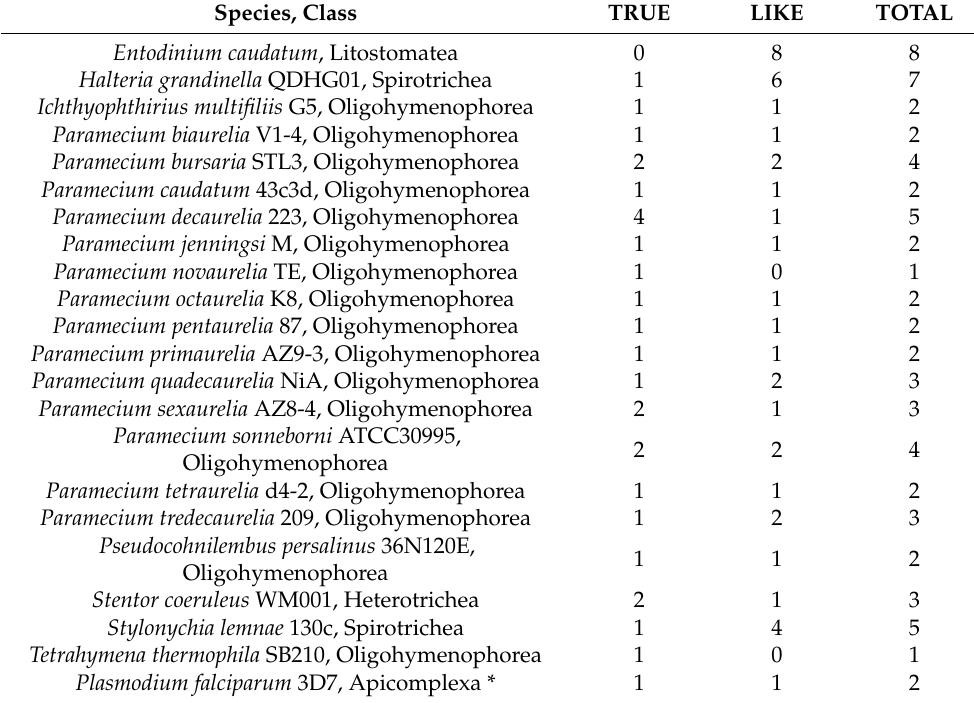
Table 2. Number of sequences in orthogroup OG0001068. The sequences listed in Table 1 were grouped according to the clusters observed in the phylogenetic tree in Figure 2. TRUE sequences are those that cluster along with P. tetraurelia CaM (GSPATG00015825001). LIKE sequences are the sequences that cluster apart from GSPATG00015825001. The leftmost column indicates the species to which the number of sequences shown in the next columns belong. Along with the species name, the Class taxonomic rank is included, except in the one marked with an asterisk, which corresponds to